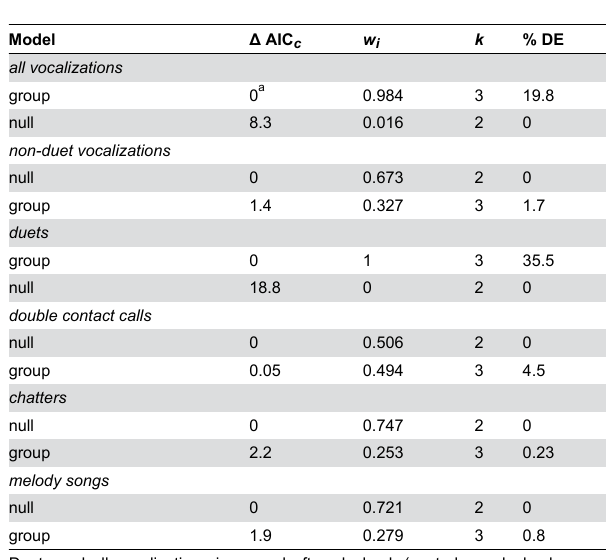
Duets and all vocalizations increased after playback (control vs. playback group effect ranked above null). Δ AIC c shows the difference between the model AIC c (Akaike’s Information Criterion corrected for small sample sizes) and the minimum AIC c in the set of models; AIC c weights ( w i ) show the relative likelihood of model i ; k indicates the number of parameters; % DE is percent deviance explained by the model. a Lowest AIC c = 401.8 (all vocalizations), 264.7 (non-duet vocalizations), 377.6 (duets), 253.0 (double contact calls), 193.1 (chatters), and 339.4 (melody songs).